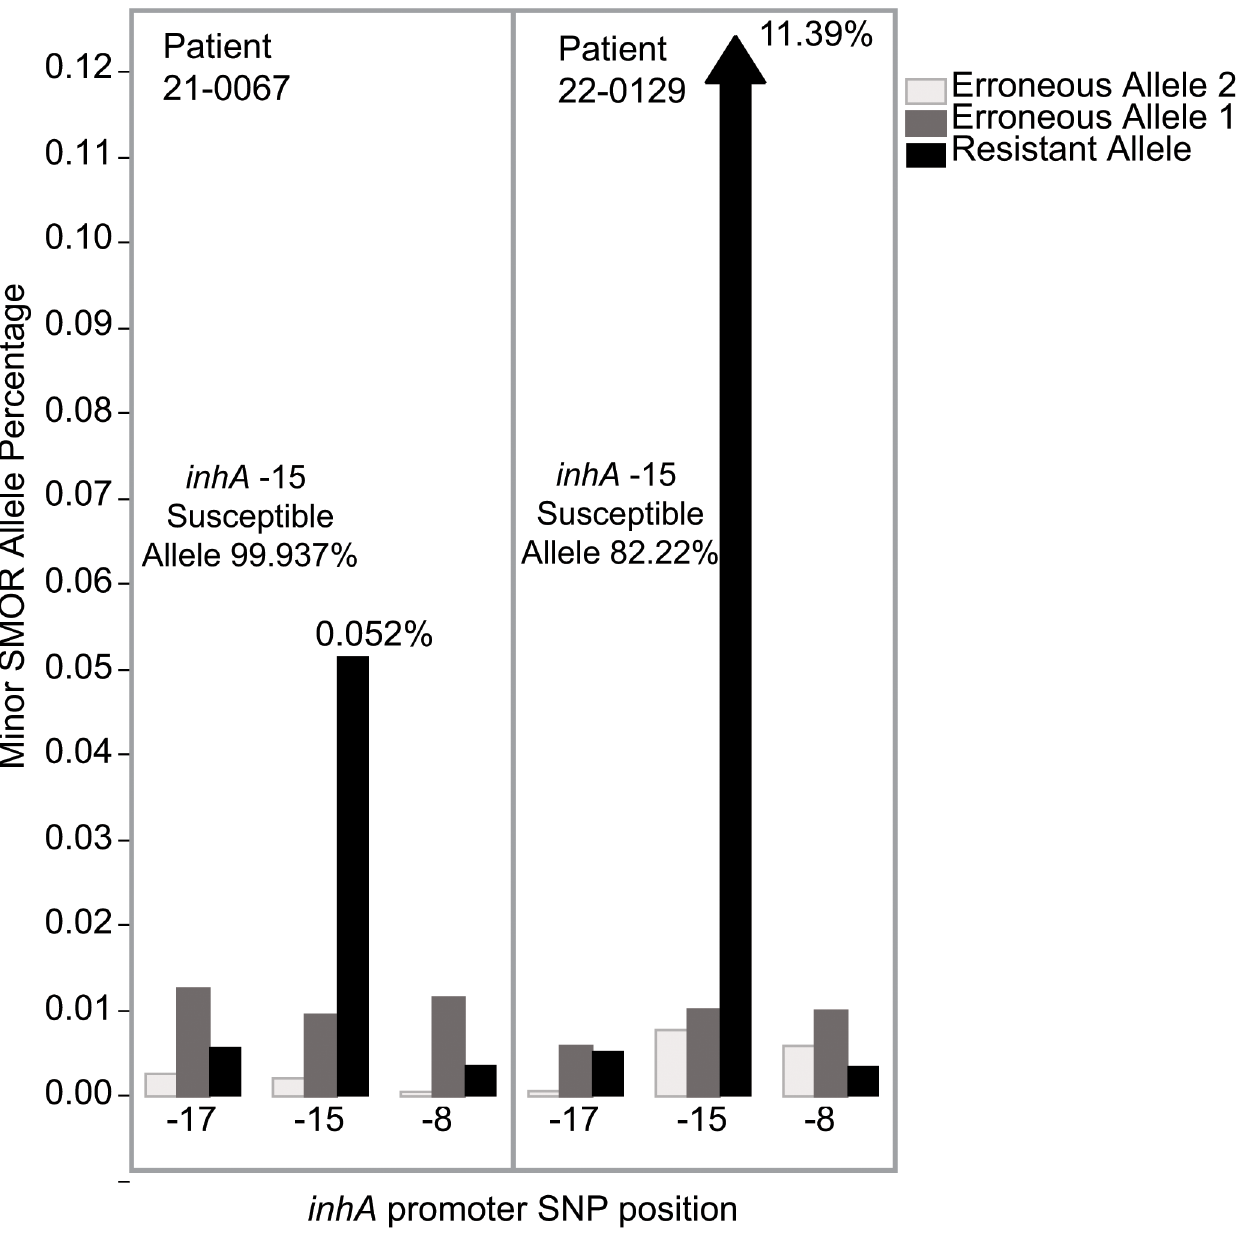
Fig 5. Minor subpopulation detection in two sputum samples from Moldova. Resistant and erroneous allele frequencies from three resistance SNP loci in the inhA promoter are shown. Patient 21 – 0067 with 0.05% resistant allele and patient 22 – 0129 with 11.39% resistant allele at inhA -15, compared to erroneous and resistant alleles below 0.01% at the other two SNP